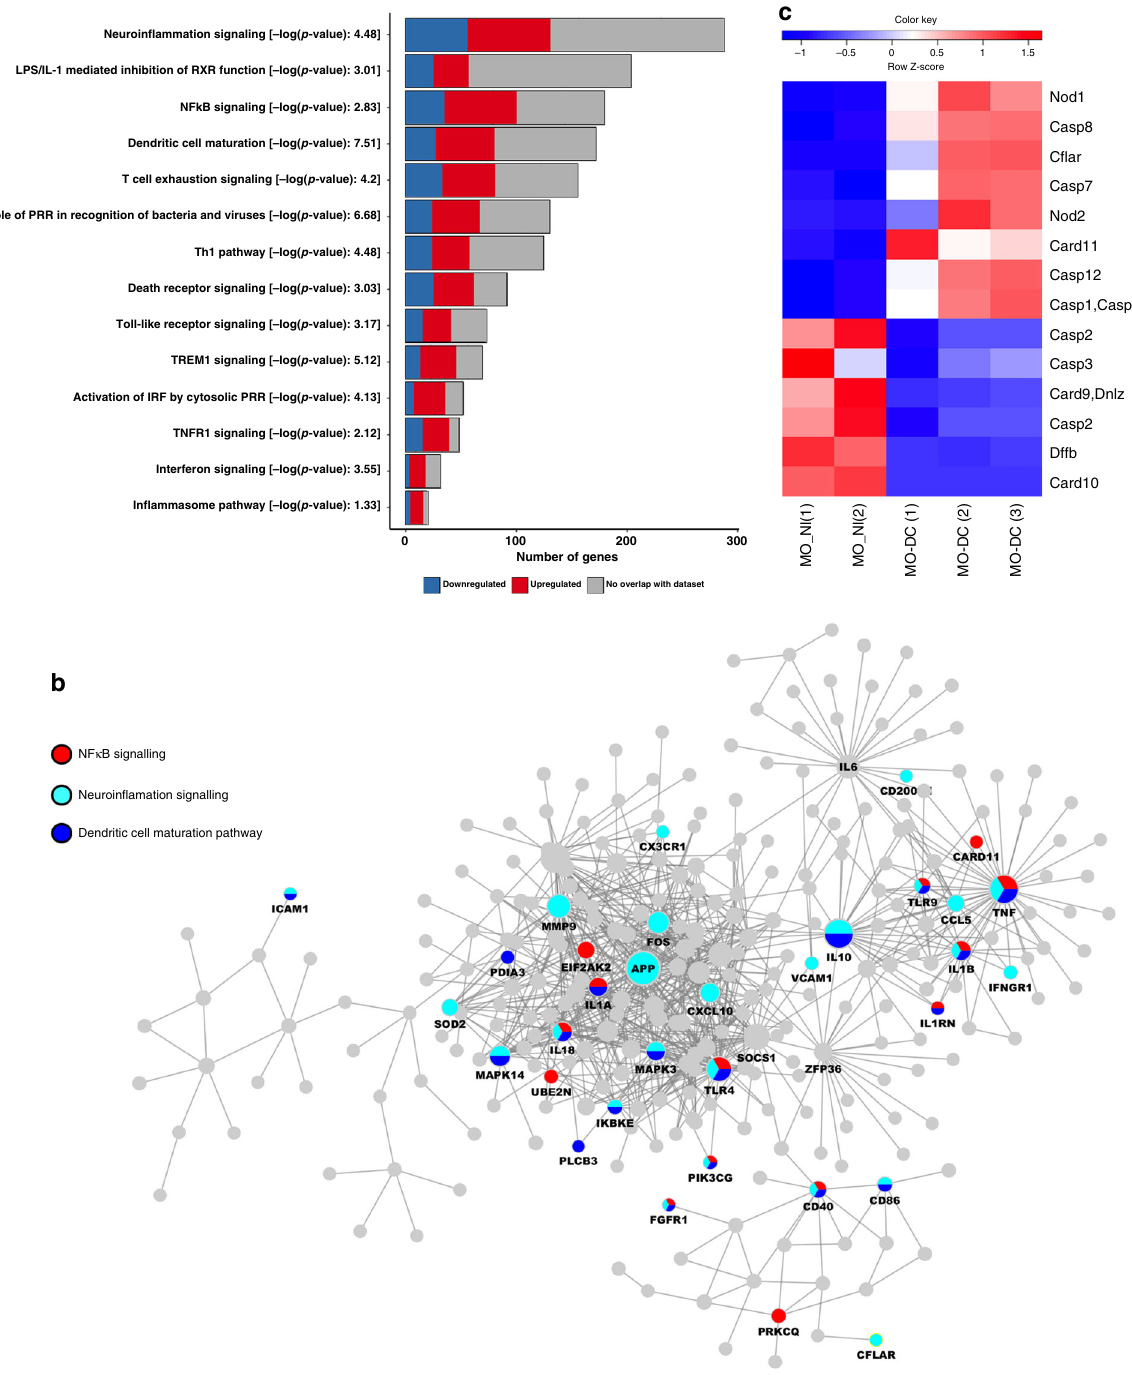
Fig. 5 Gene signatures from monocyte-derived dendritic cells (MO-DCs) from PbA -infected mice. Monocytes and MO-DCs were sorted from splenocytes from C57BL/6 controls (uninfected) mice and at 5 days post infection for RNA extraction and RNA-seq analysis. a Bar plot showing pathways signi fi cantly activated in MO-DCs from PbA -infected mice. Each color in the bar indicates the number of differentially expressed (DE) genes involved in a given pathway: in blue are downregulated, in red are upregulated, and in gray are the genes that do not show overlap with Ingenuity pathway analysis (IPA) database. b The main component of IPA network of all DE genes. All the DE genes are in gray, except the genes from NF- κ B signaling, neuroin fl ammation, and dendritic cell differentiation pathways, which have been highlighted of red, light blue, and dark blue, respectively. c Heatmap illustrates the expression of genes from caspase family in highly puri fi ed (over 98% purity) splenic MO-DCs (CD11b + F4/80 + CD11c + DC-Sign + MHC II + ) from PbA -infected C57BL/ 6 mice compared to splenic monocytes (MO, CD11b + F4/80 + CD11c − DC-Sign − MHC II − ) from uninfected controls (NI). The color scheme represents the row Z